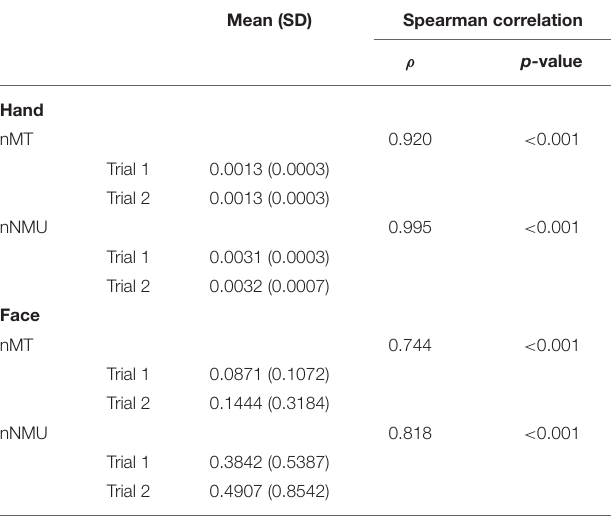
TABLE 1 | Characteristics of participants. TABLE 2 | Test–retest correlation of kinematic variables in participants ( N =